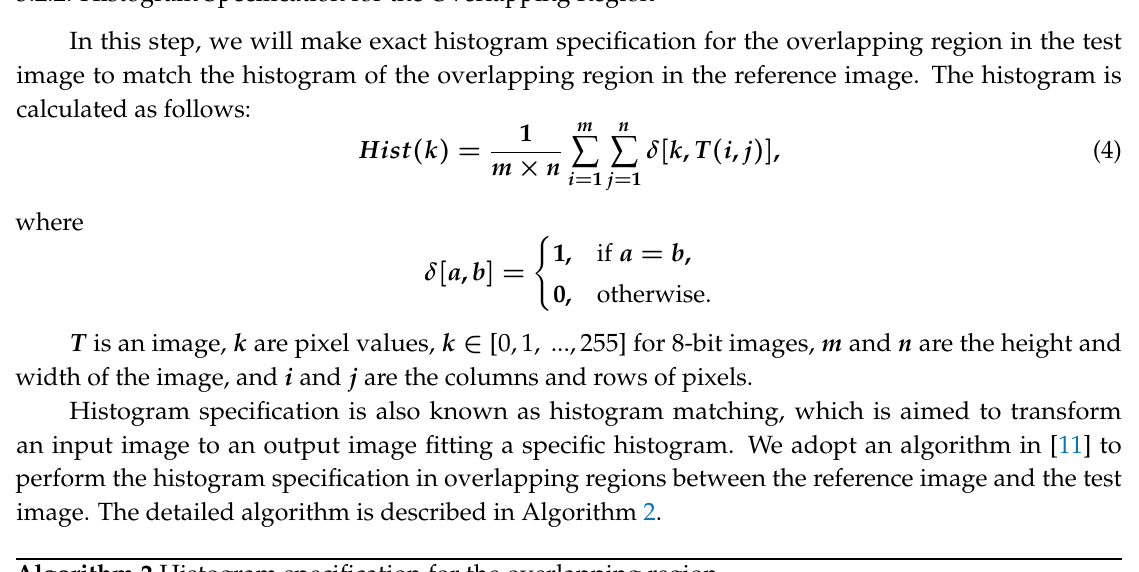
Algorithm 2 Histogram specification for the overlapping